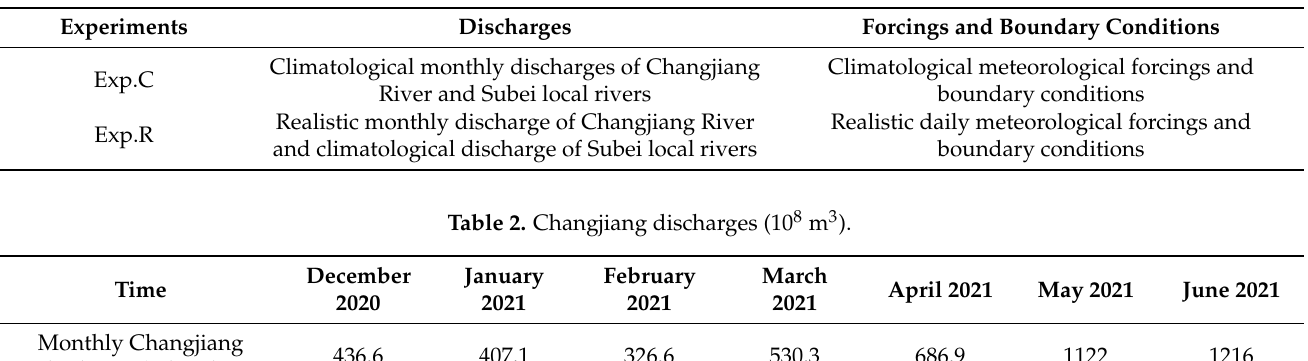
Table 1. List of experiments.